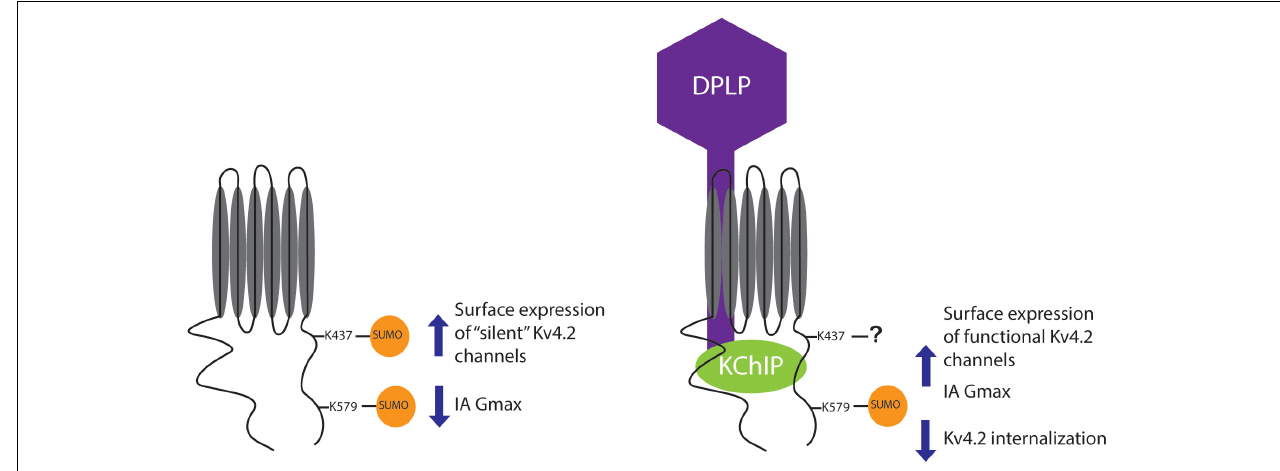
FIGURE 10 | Summary. The cartoon summarizes the effects of Kv4.2 SUMOylation when Kv4.2 is expressed alone versus co-expressed with KChIP2a and DPP10c. Note that the question mark indicates that when Kv4.2 is comprised by the TC, K437 may or may not be SUMOylated, and preventing K437 SUMOylation does not alter the effect of enhanced SUMOylation on channel surface expression and IA